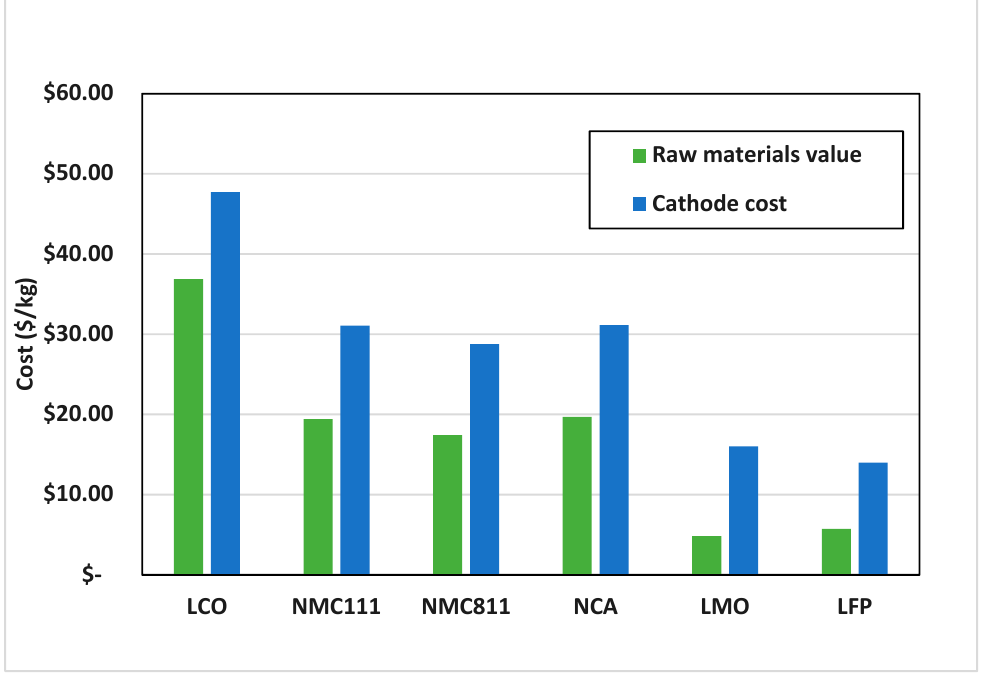
Figure 4. Estimated cathode cost vs. constituent cost.